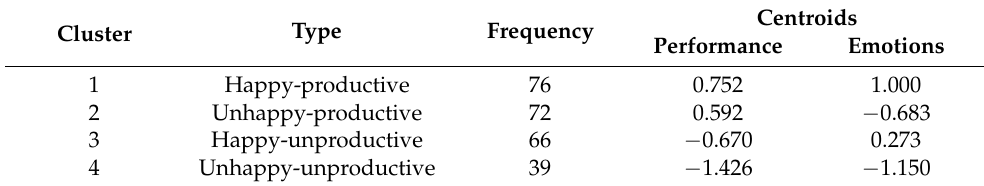
Table 5. Four-cluster solution, cluster standardized means and group-sizes for Emotions and Job Performance (Study 2; N =